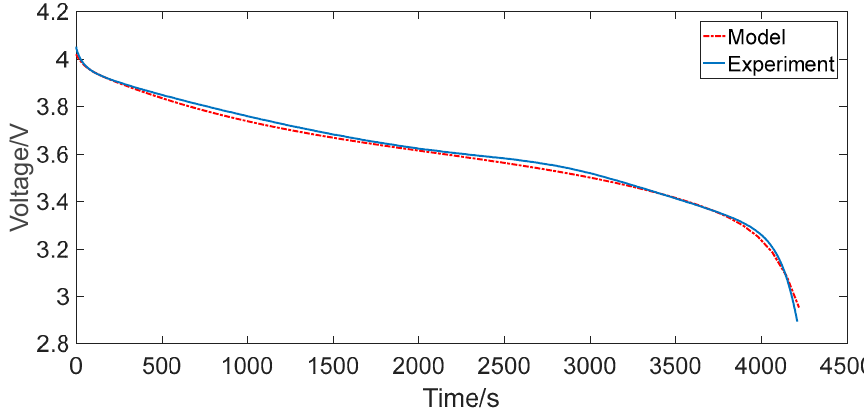
Figure 12. The simulation output of the second-order RC model for 1C constant current discharging.